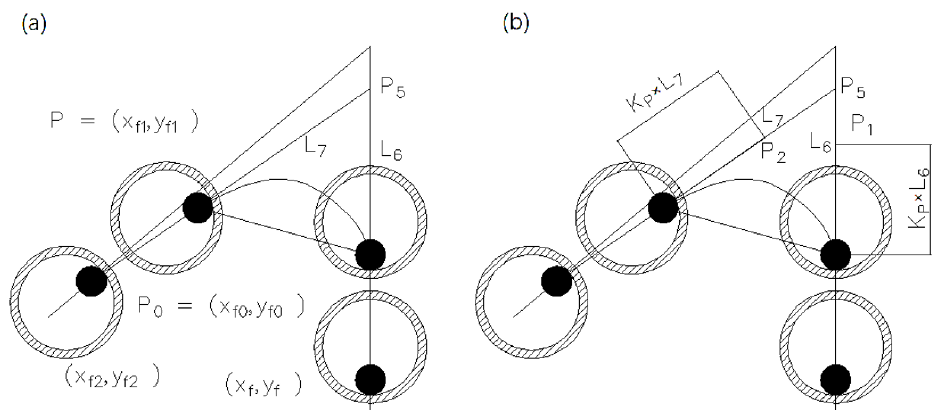
Figure 20. Schematic diagram of bridging the transition curve, ( a ) control line at bridge, ( b ) schematic diagram of variable control points.